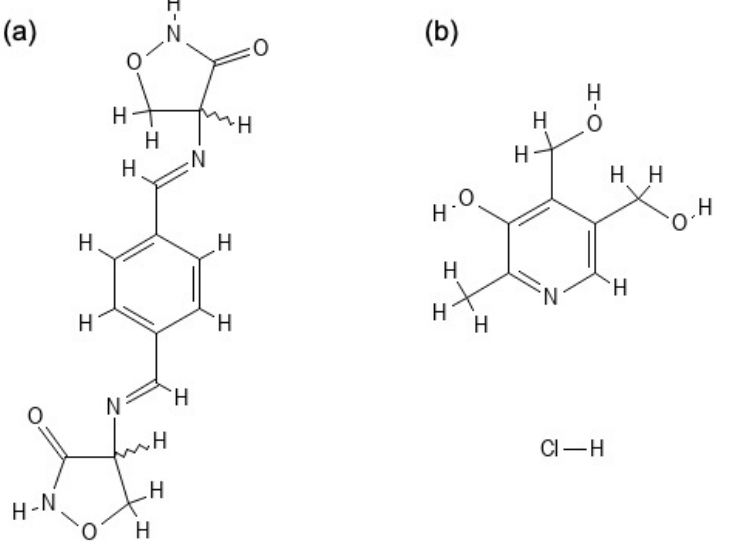
Figure 1. Molecular structures of ( a ) TZD and ( b ) PDX